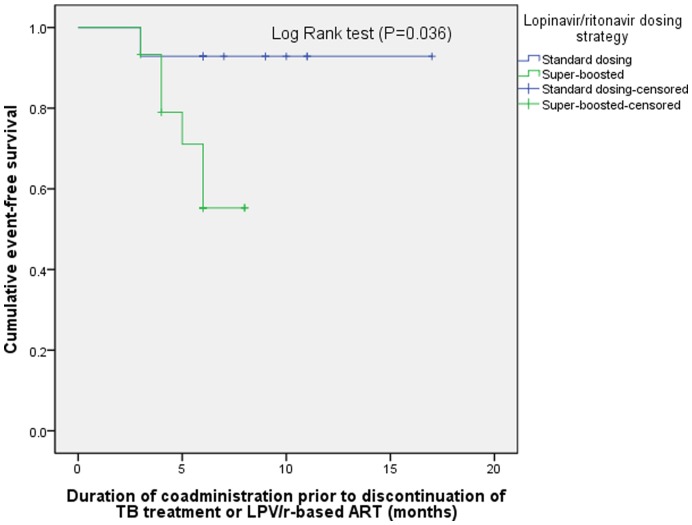
Kaplan-Meier survival curve for the impact of lopinavir/ritonavir dosing strategy among patients with HIV/TB coinfection on time until treatment discontinuation.